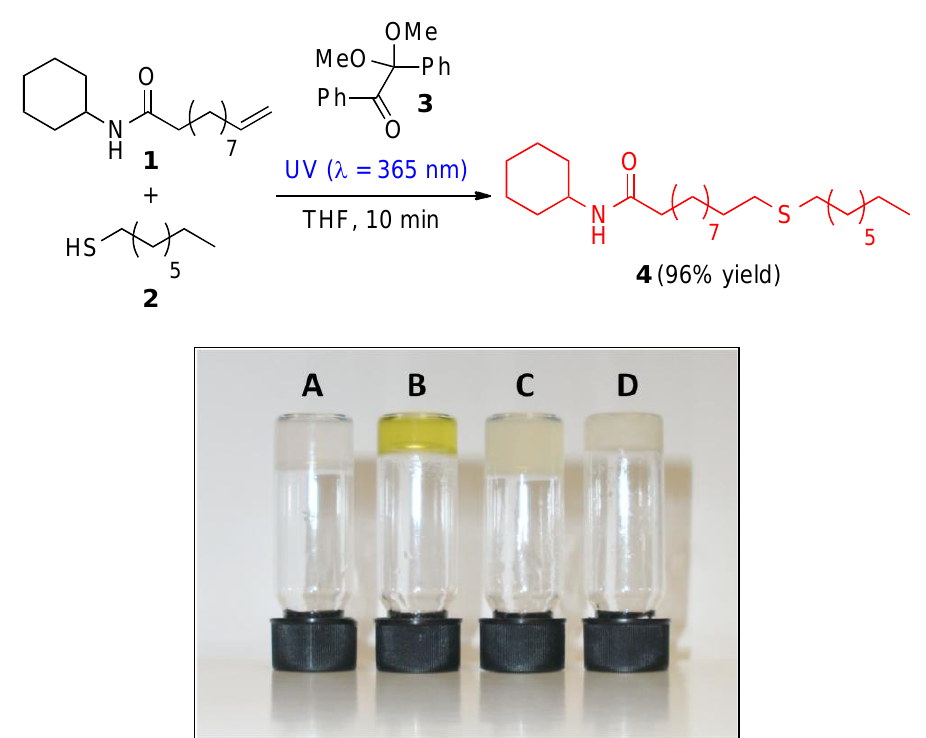
Figure 1. Synthesis of gelator N -cyclohexyl-11-(octylthio)undecanamide ( 4 ) and gels made in silicone oil (vial A , MGC = 0.5 wt.%, T = 39 ± 3 °C), olive oil (vial B , gel MGC = 0.8 wt.%, T = 27 ± 3 °C) [8], rapeseed oil (vial C , MGC = 0.8 wt.%, gel T = 27 ± 3 °C) and ionic liquid C MIMCl (vial D , MGC = 0.7 wt.%, T = 44 ± 3 gel 10 gel